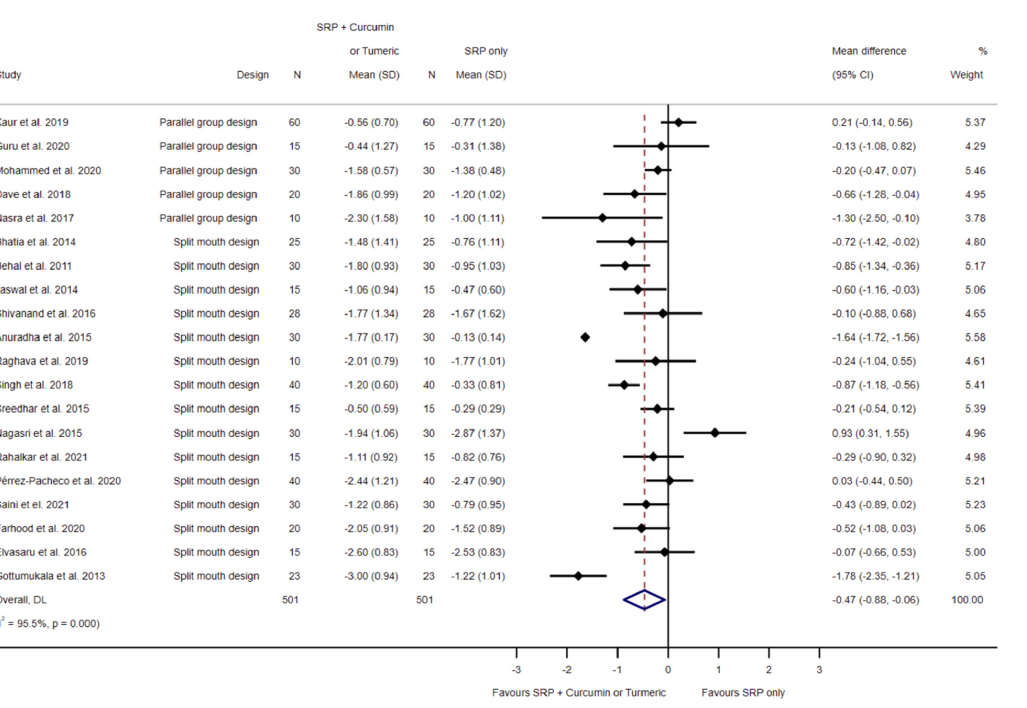
Figure 4. Forest plot for the comparison of SRP and chlorhexidine to SRP and local curcumin/tur- meric related to clinical attachment level loss [47–52].